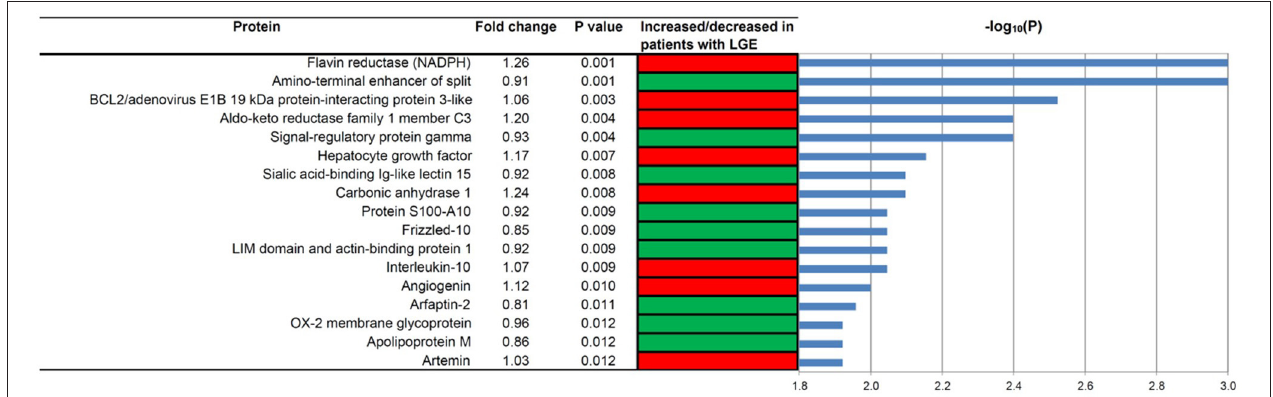
FIGURE 3 | The 17 most discriminant proteins to distinguish patients with and without late gadolinium enhancement in the hypertrophic cardiomyopathy population. A red box indicates that the protein concentration was increased in patients with LGE, while a green box means that the concentration was decreased in patients with LGE. P values were computed using the Mann-Whitney-Wilcoxon test. Fold change was calculated by dividing the median in the cases by the median in the controls. HCM, hypertrophic cardiomyopathy; LGE, late gadolinium enhancement.